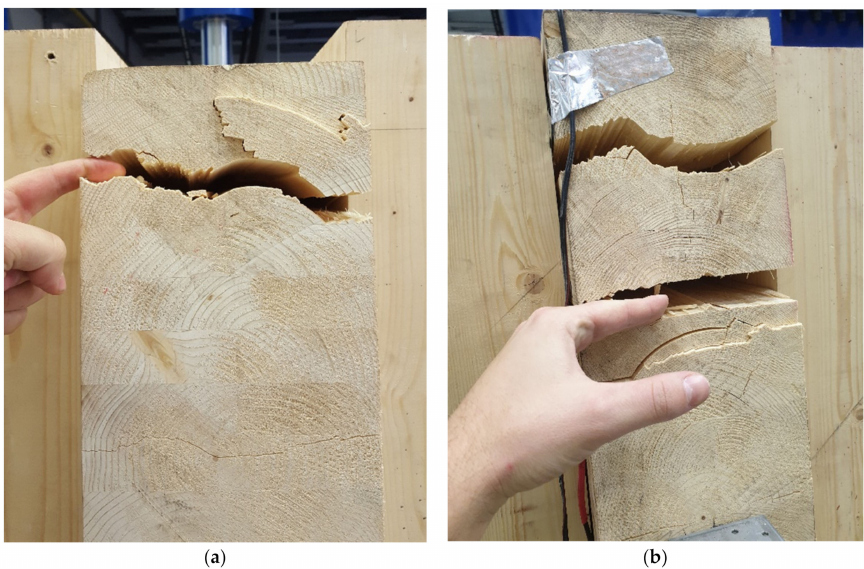
Figure 19. Experiment no. 2: ( a ) damage test sample no. 1; ( b ) damage test sample no.